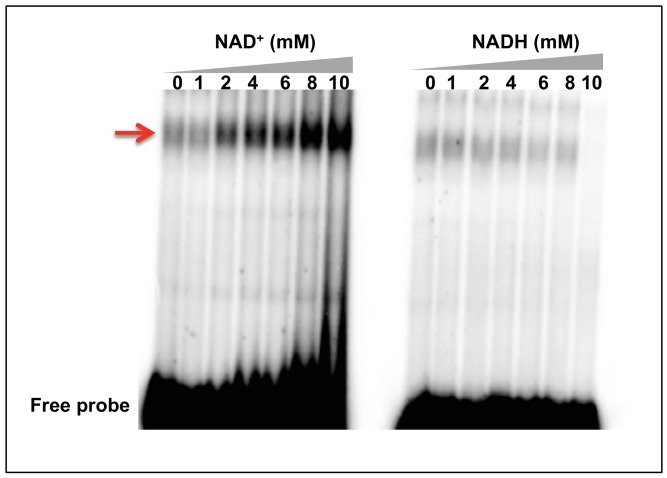
NAD+ but not NADH facilitates DNA binding.Representative EMSA results with recombinant ERM-BP and radiolabeled ERM in presence of different concentrations of NAD+ or NADH (0, 1, 2, 4, 6, 8 and 10 mM). Gel shifted bands are shown by red arrow.